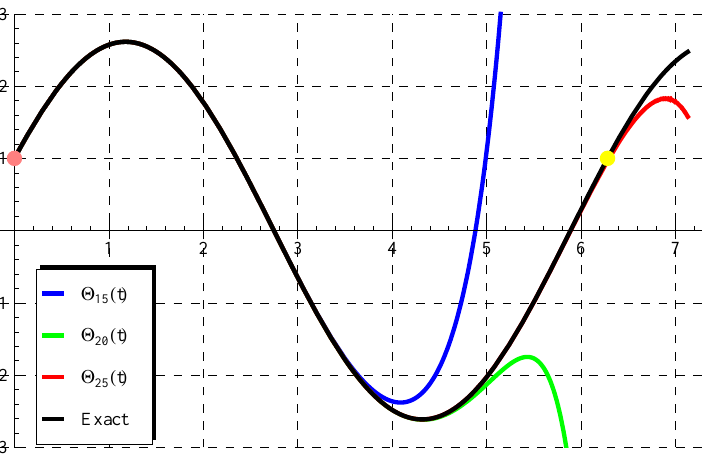
Figure 3. Comparisons between the approximate solutions Θ r ( t ) , r = 15,20, 25 in Equation (75) and the exact periodic solution (73) at λ = 1, a = 1, b =